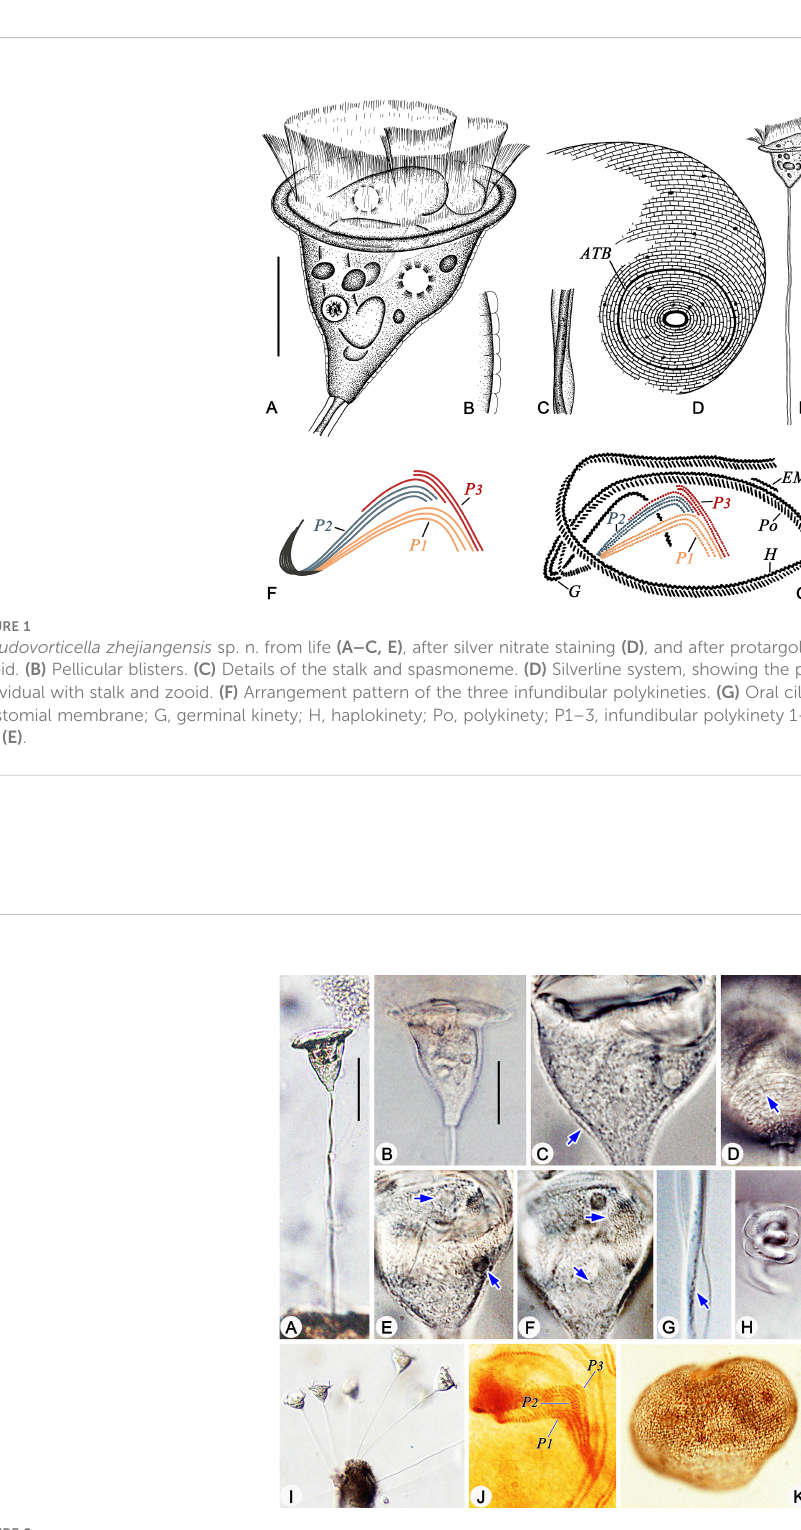
FIGURE 2 Photomicrographs of Pseudovorticella zhejiangensis sp. n. in vivo (A – I) , after protargol staining (J) and after silver nitrate staining (K) . (A, I) Typical complete individuals. (B) Zooid in typical shape. (C) Pellicular blisters (arrow). (D) Pellicular striations (arrow). (E) Macronucleus (arrows). (F) Arrows indicate the two contractile vacuoles, one dorsal and another ventral. (G) Details of the stalk and spasmoneme; arrow points to granules. (H) Helically contracted stalk. (J) Infundibular part of the oral ciliature, showing the three polykineties. (K) Overview of the silverline system. Abbreviations: P1 – 3, infundibular polykinety 1 – 3. Scale bars: 60 m m (A) and 30 m m (B)